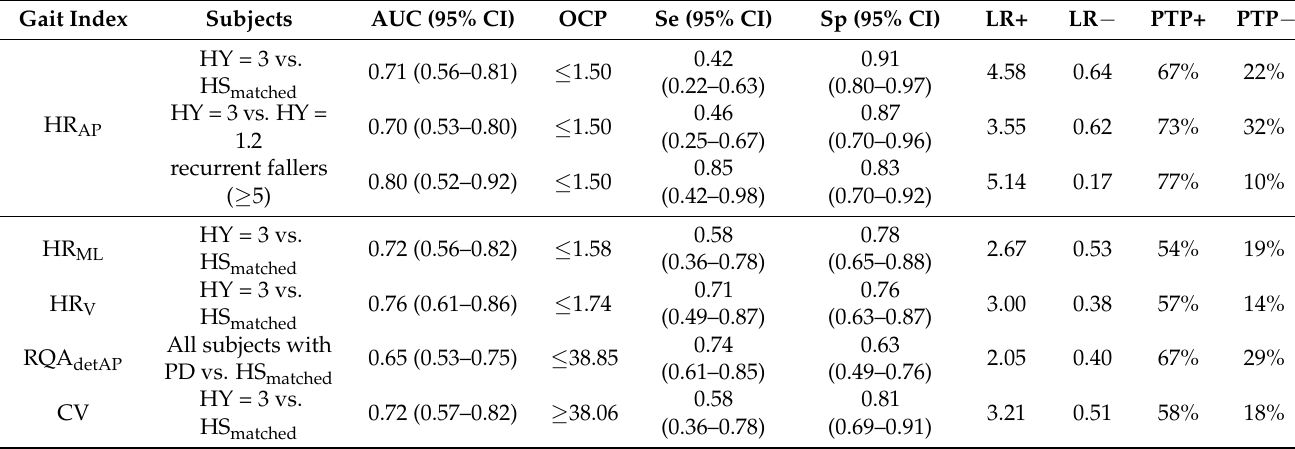
Table 2. ROC curve and cutoff analysis results.